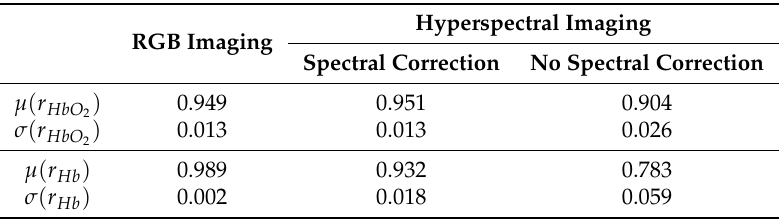
Figure 11. Hemodynamic monitoring following neuronal activation computed with RGB imaging. The dashed lines represent the theoretical hemodynamic responses following the neuronal stimulation. The dispersion ranges of the measurements are represented by colored areas. The concentration changes averaged over the 10 3 noisy measurements are represented in solid lines. The concentration changes’ time courses computed with the 121 wavelengths included between 780 nm and 900 nm [23] are represented with yellow points. The ones computed with Arifler et al.’s wavelengths [27] are represented with black triangles. The blue rectangle represents the “patient” physiological stimulus. Table 4. Pearson correlation coefficients computed between the theoretical hemodynamic responses and the simulated concentration changes’ time courses; see Figures 10 and 11. µ ( r n ) and σ ( r n ) designate the mean and standard deviation, respectively, of the Pearson correlation coefficients computed with the 10 3 noisy time courses of the chromophore n